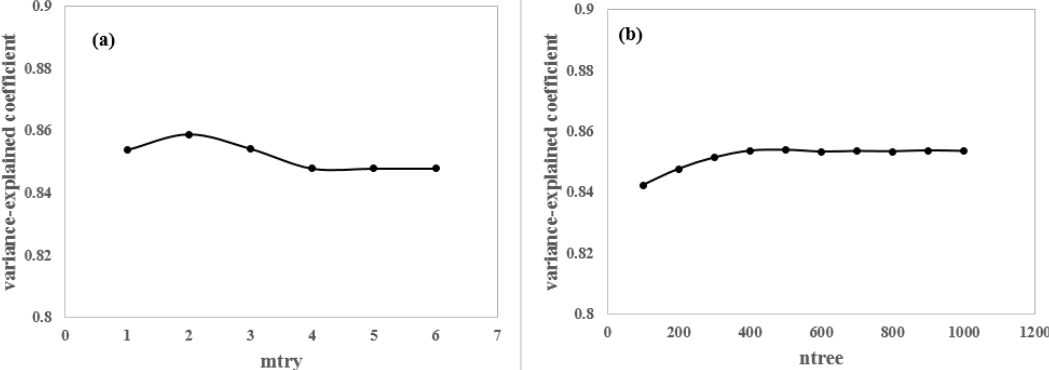
Figure 2. Dependence of the variance-explained coefficient R 2 on the parameters Mtry ( a ) and Ntree ( b ).